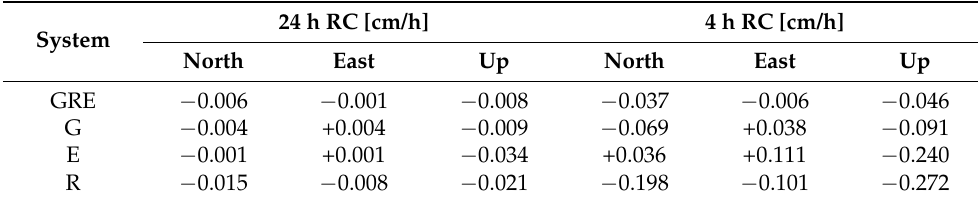
Table 8. The slope regression coefficient for SD